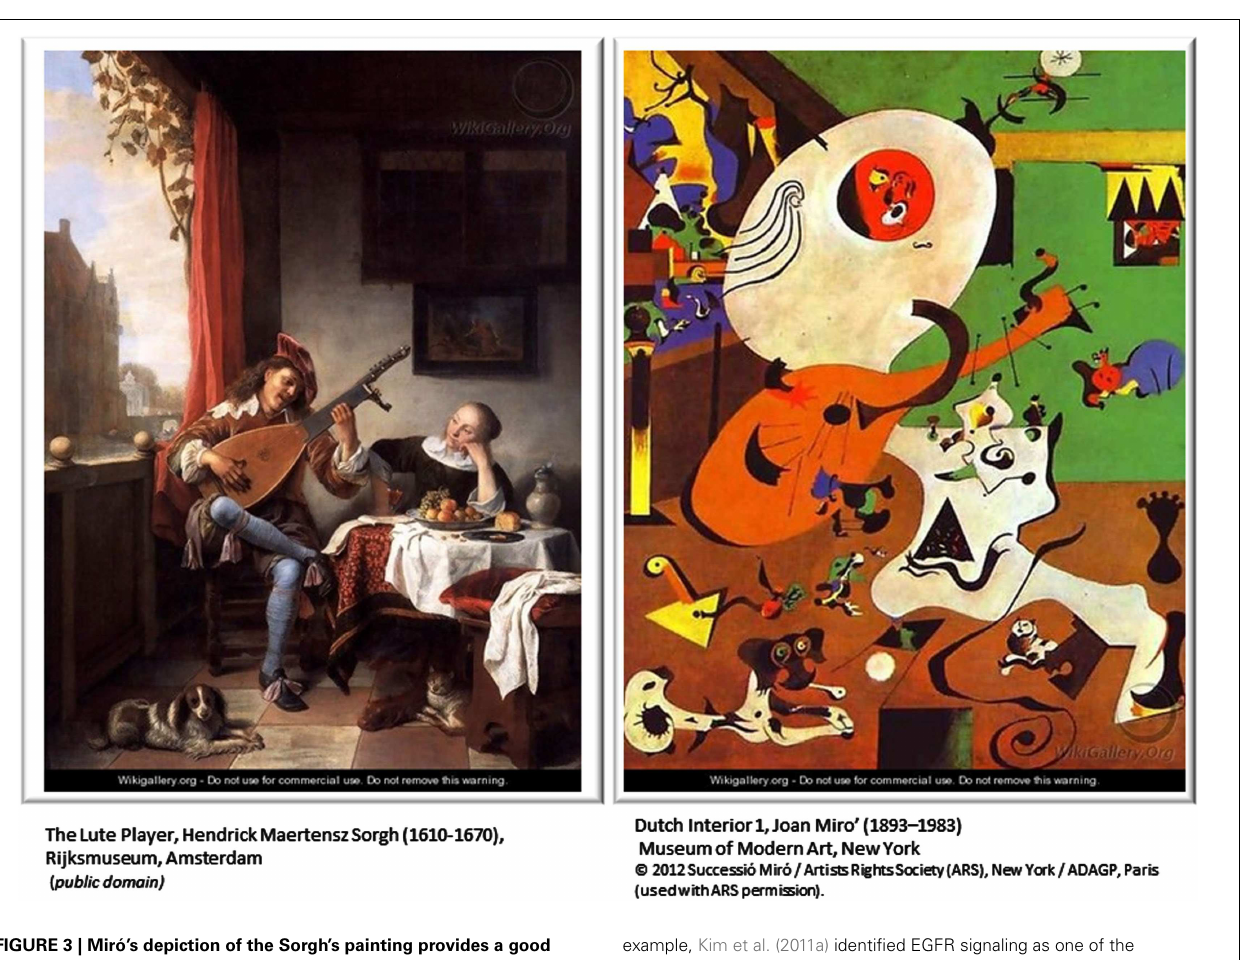
FIGURE 3 | Miró’s depiction of the Sorgh’s painting provides a good analogy for the relation between computationally inferred subnetworks and true biological pathways. Such subnetworks provide somewhat distorted depiction of real relationships within the cell and while general components are distinguishable, much of the details are inaccurate. For